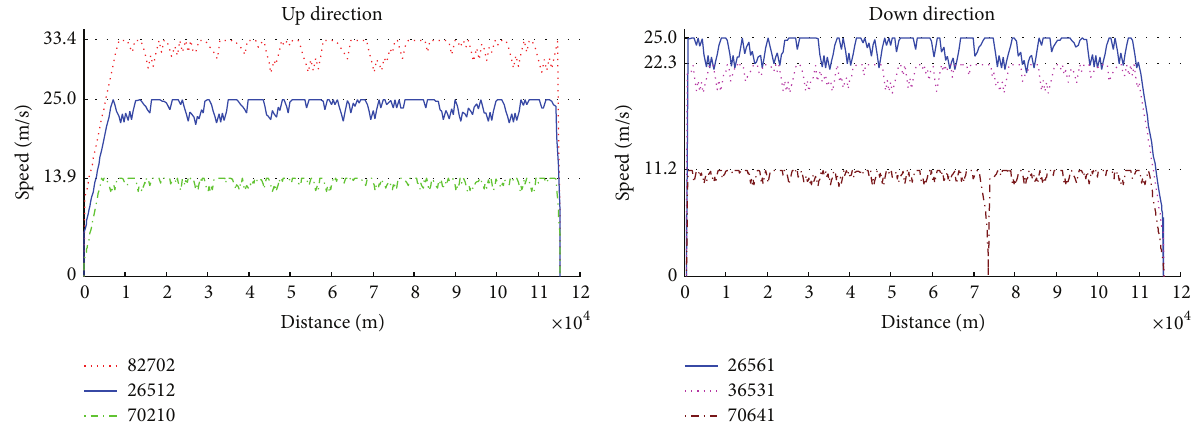
Figure 7: Train speed-distance curve (section 3 is 30000 m, with NCBS).